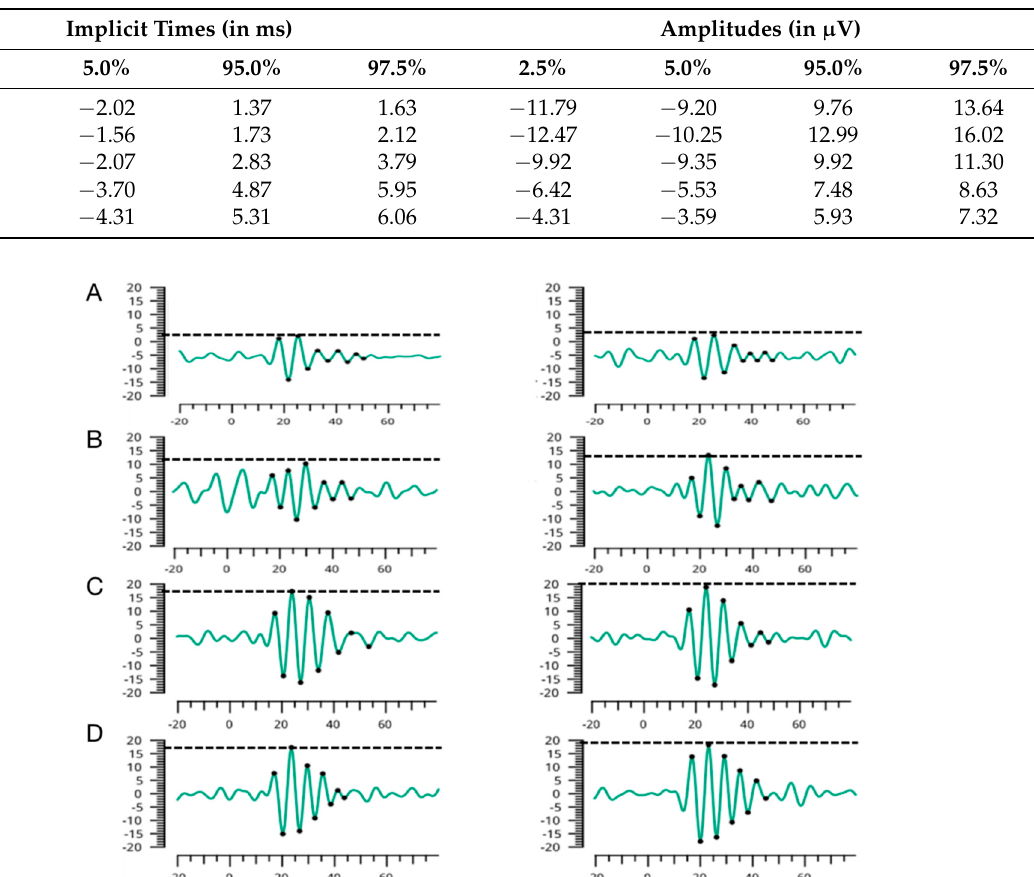
Figure 4. Representative OPs in children of different ages. Representative OPS of both eyes are shown for a 4-month_x0002_old infant ( A ), and 5-year-old ( B ), 7-year-old ( C ), and 10-year-old ( D ) healthy children. Dashed lines indicate the highest peaks. Table 2. Additive amounts for 2.5%, 5%, 95%, and 97.5%.